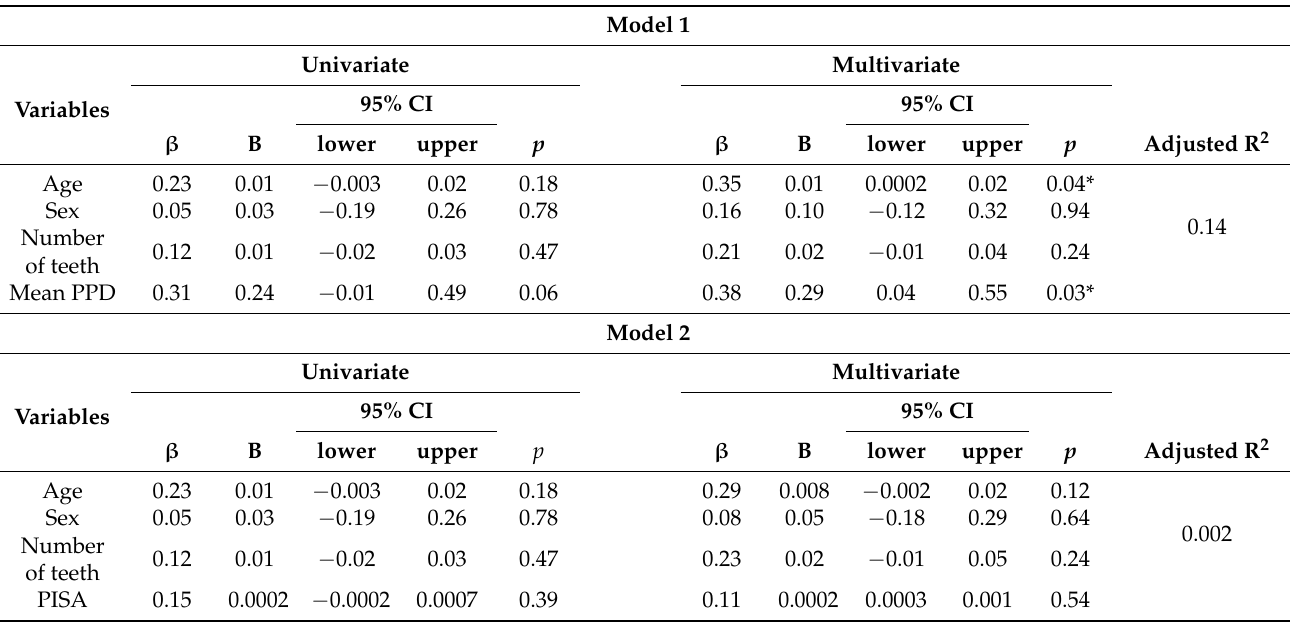
Table 2. Multivariate analysis of the association between PPD or PISA and HbA1c in patients with mild diabetes mellitus. (N =